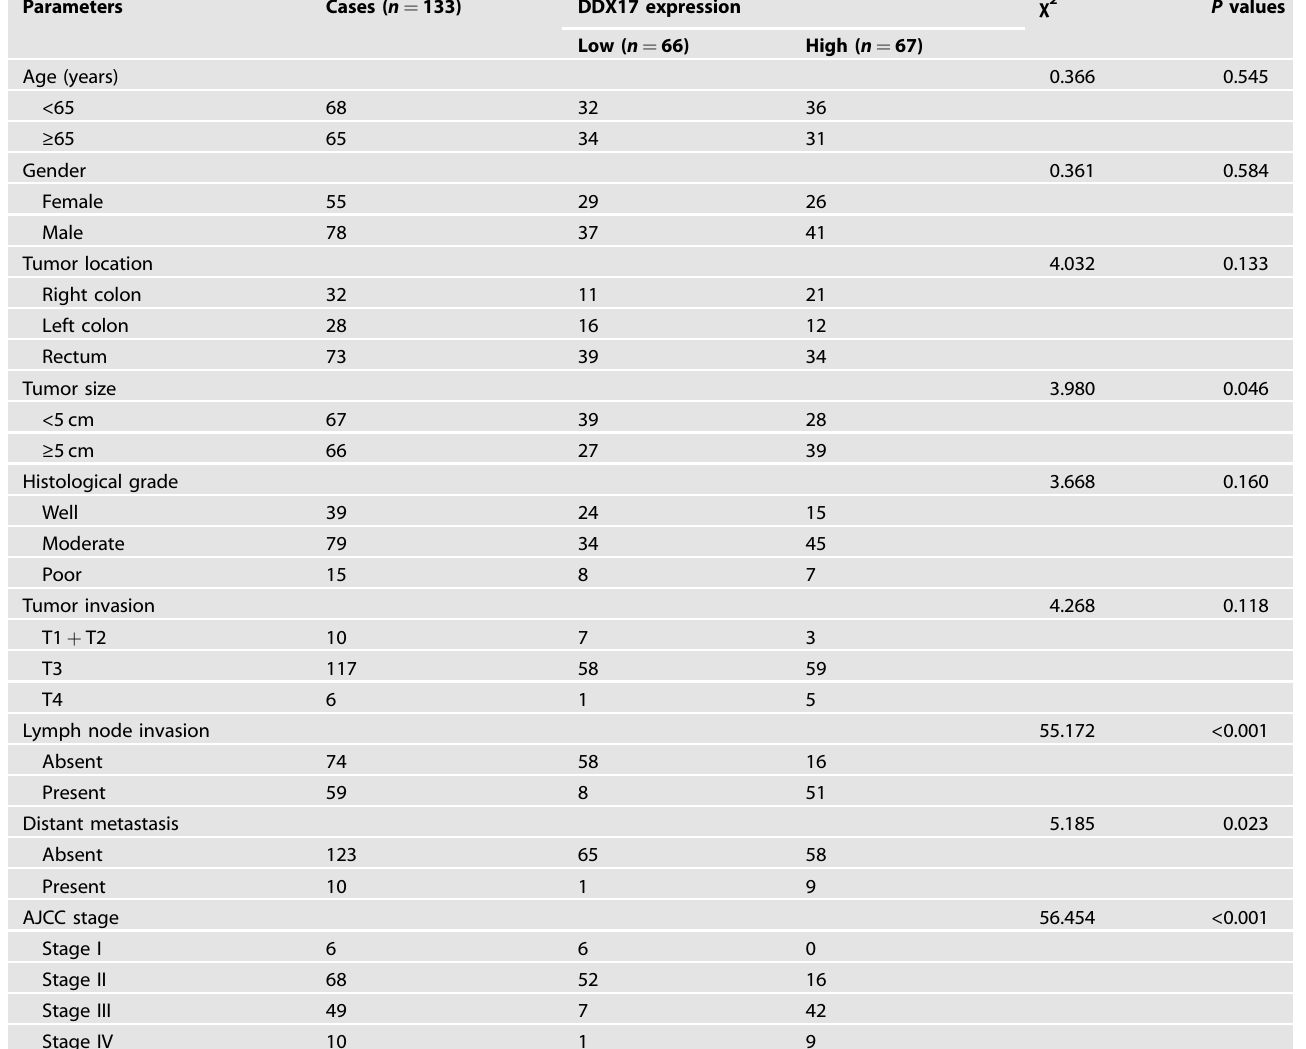
Table 1. The correlation of DDX17 expression and clinicopathological characteristics of CRC patients.